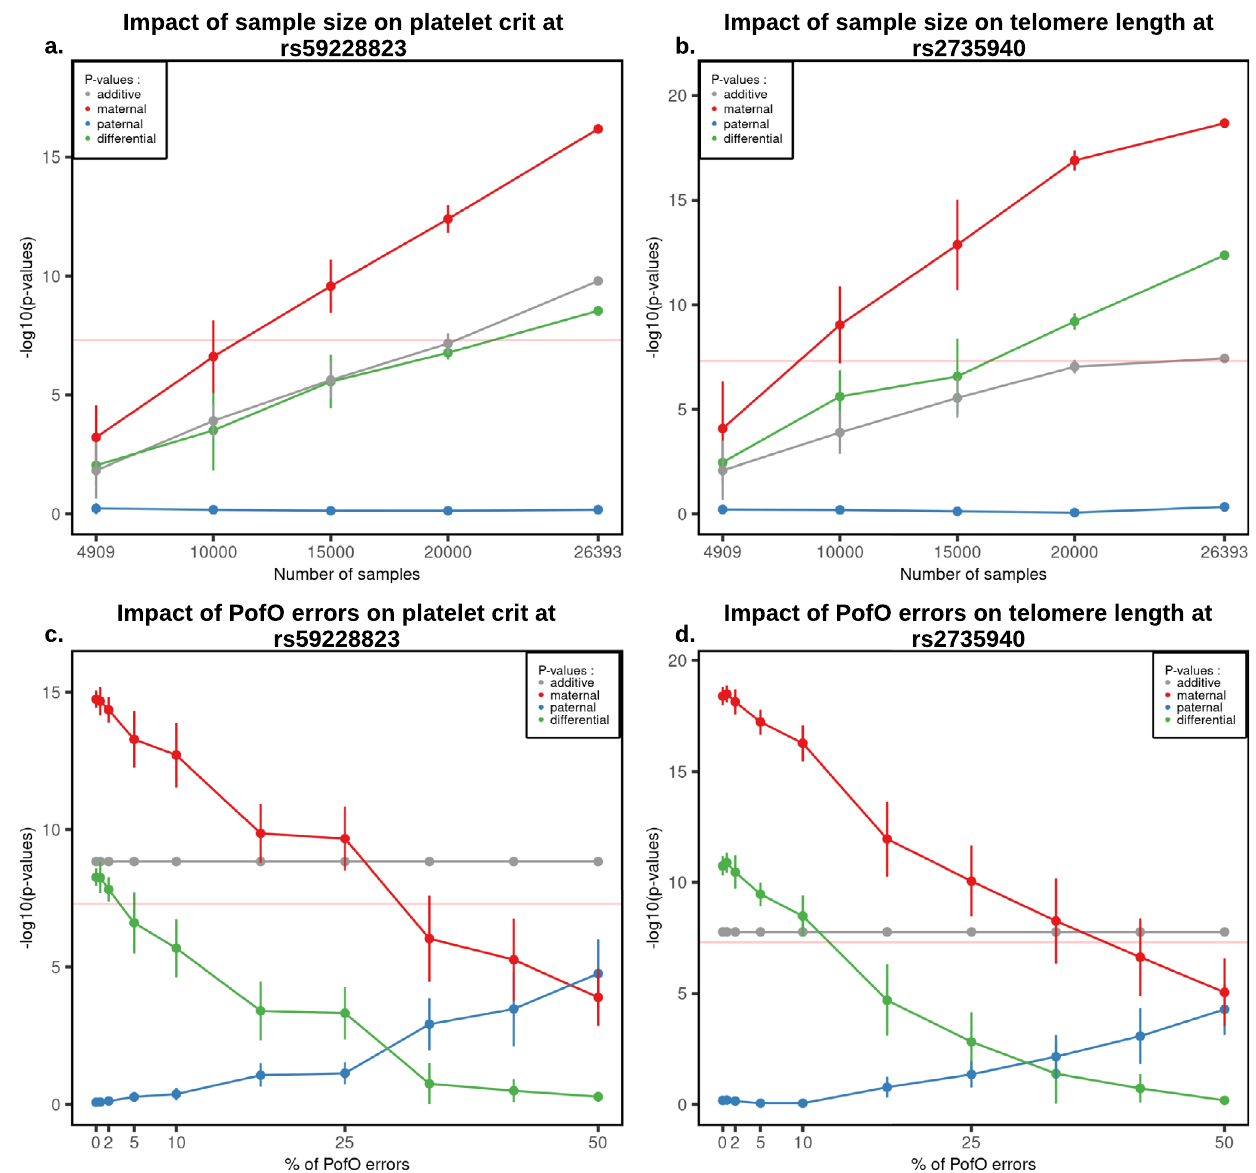
Fig. 5 | Robustness of the PofO testing. a , b Association strength as − log10( p - value)forrs59228823andrs2735940( y -axis)onplateletcritandTL,respectively,as a function of the number of randomly chosen samples included in the analysis under the additive (black), paternal (blue), maternal (red) and differential (green)scans.Eachpointfor N =[10,000;15,000;20,000]representsthemedian p - valueobtainedafter10randomizationswithverticalbarsrepresentingthestandard error. Points for N =4909 and N =26,393 represent the p -values obtained using only the samples with genotyped parents and using our full sample size,